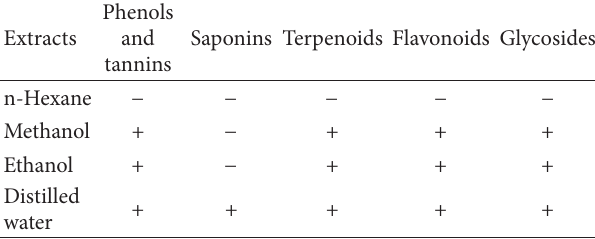
Table 1: Phytochemical constituents of Psidium guajava